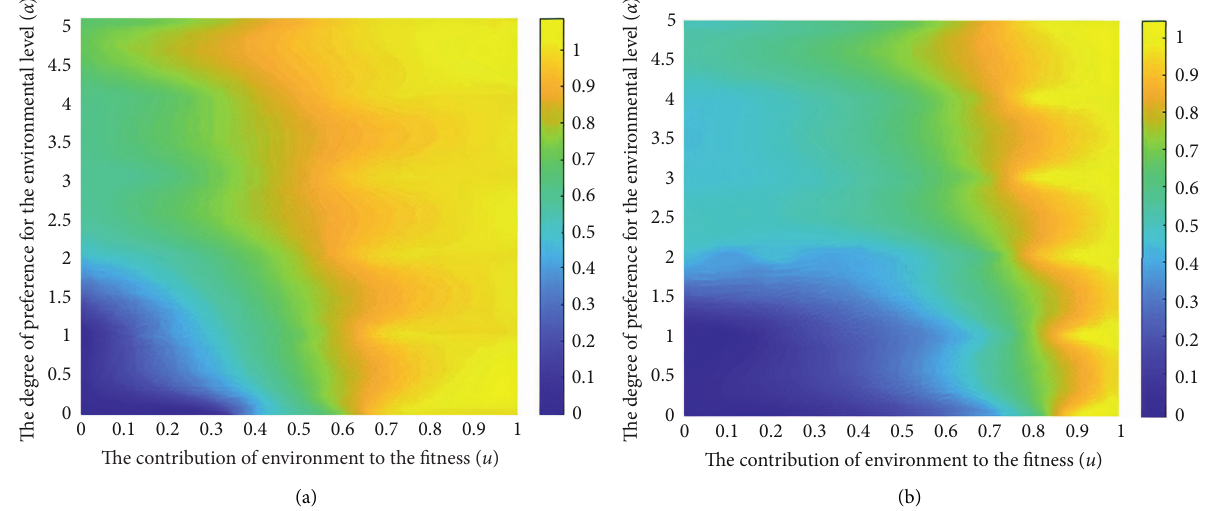
Figure 11: The colour-coded (see the bar on the right) density of cooperation ρ b � 1.3 ((a) for the PDG) and r � 0.8 ((b) for the SDG). The yellow shading corresponds to the higher stationary density of cooperators.